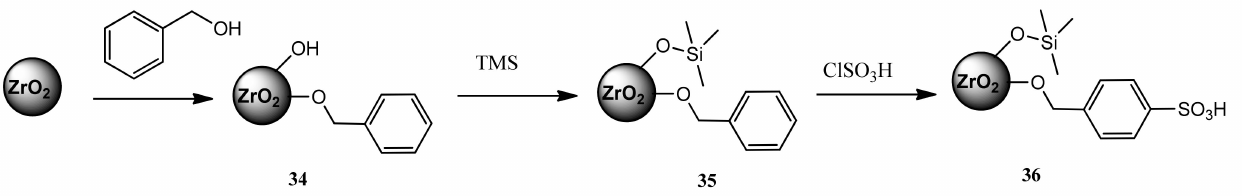
Figure 13. Benzylsulfonic acid-functionalized mesoporous ZrO 2 from ref.